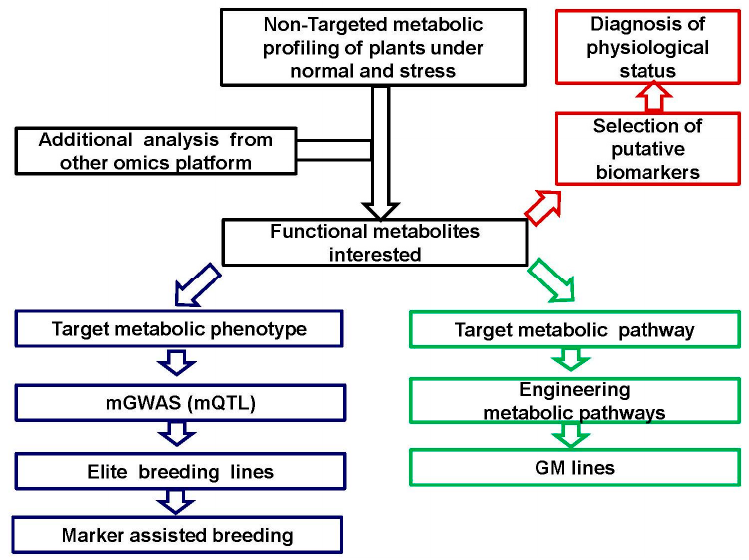
Figure 1. The schematic presentation of plant metabolomics and its application in plant improvement.